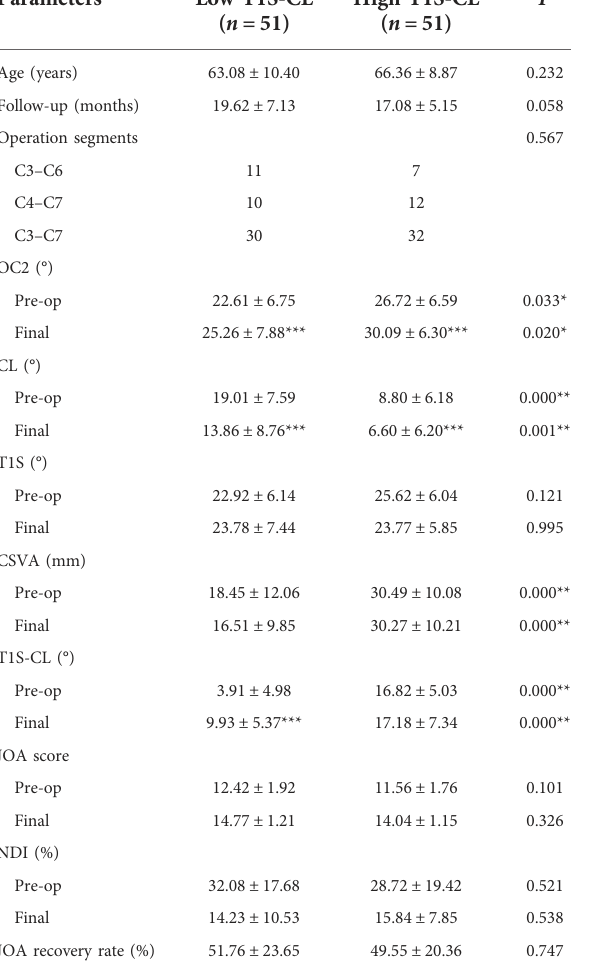
TABLE 3 Comparison of cervical sagittal parameters and HRQOL indicators between the low T1S-CL group and the high T1S-CL group. Parameters